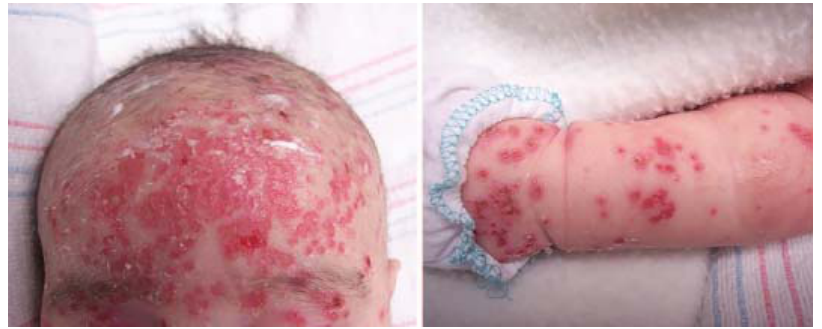
Figure 13. Eczema